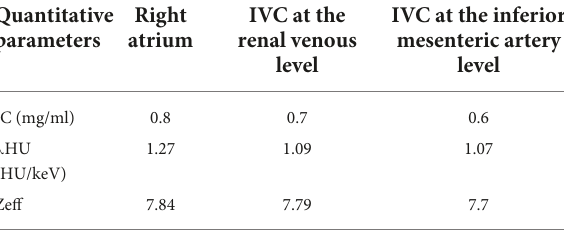
TABLE 3 Quantitative dual-energy computed tomography (DECT) parameters between inferior vena cava and right atrial mass. Quantitative